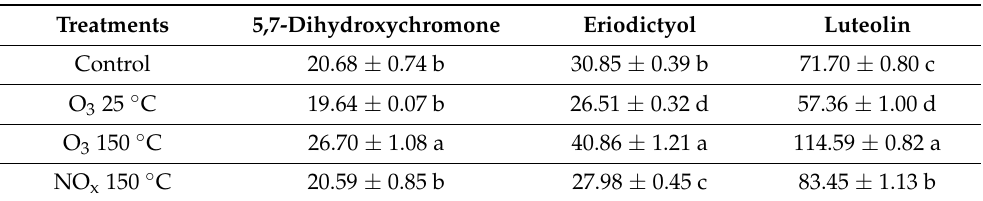
Table 1. Content of 5,7-dihydroxychromone, eriodictyol, and luteolin (mg/g extract) in atmospheric- pressure plasma-treated peanut